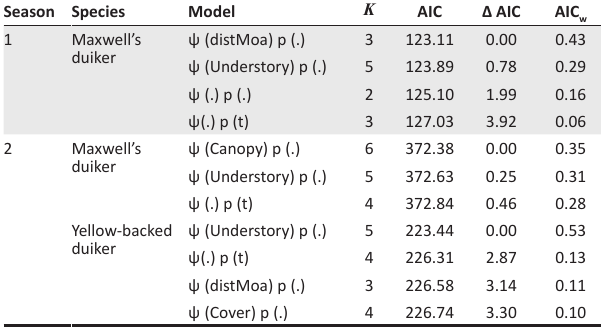
TABLE 2: Occupancy analysis of Maxwell’s and yellow-backed duikers determined from camera trapping data on Tiwai Island and vicinity, Sierra Leone, during